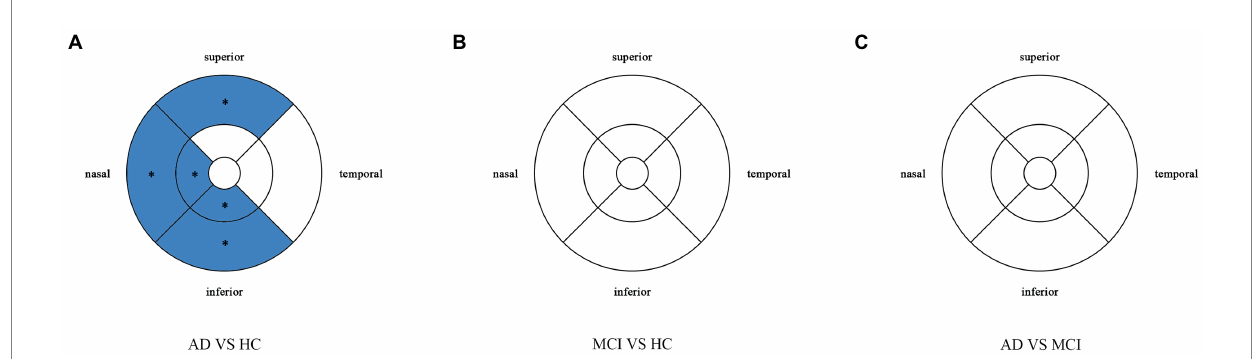
FIGURE 2 Comparison of vessel density in macular among the AD, MCI, and HC groups. Blue regions indicate that the vessel density of the former decreases significantly in these areas compared to the latter. (A) In the AD group, the vessel density significantly reduces in the nasal and inferior regions of inner ring, and in the nasal, superior and inferior regions of outer ring as compared to HC group. (B,C) There is no significant difference between MCI group and HC group, and between AD group and MCI group. *Significant at p < 0.05. AD, Alzheimer’s disease; MCI, mental cognitive impairment; HC, healthy controls.